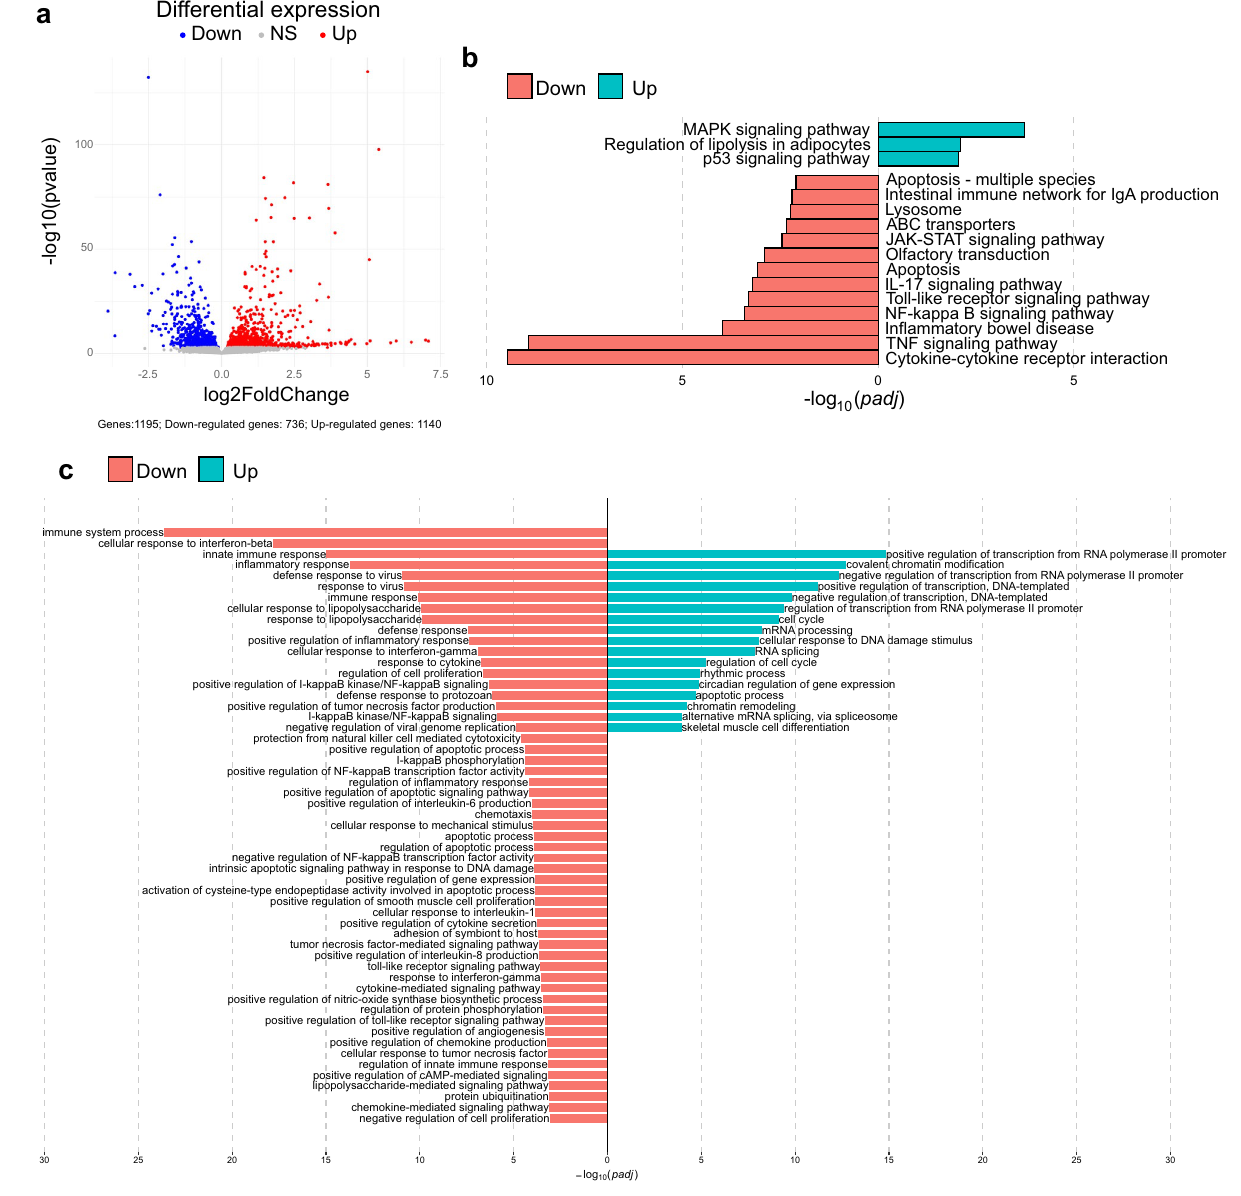
Figure 2. 3-oxo-C12:2-HSL modulates gene expression in RAW264.7 macrophage cells. Cells were stimulated with LPS and IFNγ in absence (control) or in presence of 50 µM 3-oxo-C12:2-HSL for 2 h. ( a ) Volcano plot of differentially expressed genes between the activated cells cultured in absence and in presence of 3-oxo-C12:2- HSL. Blue, grey and red dots represent down regulated, not significantly regulated and up regulated genes respectively. ( b ) Significant KEGG pathways involved in the inflammation process and differentially modulated by 3-oxo-C12:2-HSL were identified by EGSA method (p < 0.01). Red and green bars represent down-regulated and up-regulated pathways respectively. All significant modulated pathways are displayed in Supplementary Fig. 2. ( c ) Significant Gene Ontology (GO) biology processes enriched by differentiated expressed genes modulated by 3-oxo-C12:2-HSL. Terms were annotated using the Database for Annotation, Visualization and Integrated Discovery (DAVID). Red and green bars represent down-regulated and up-regulated pathways respectively. GO Gene Ontology, KEGG Kyoto Encyclopedia of Genes and